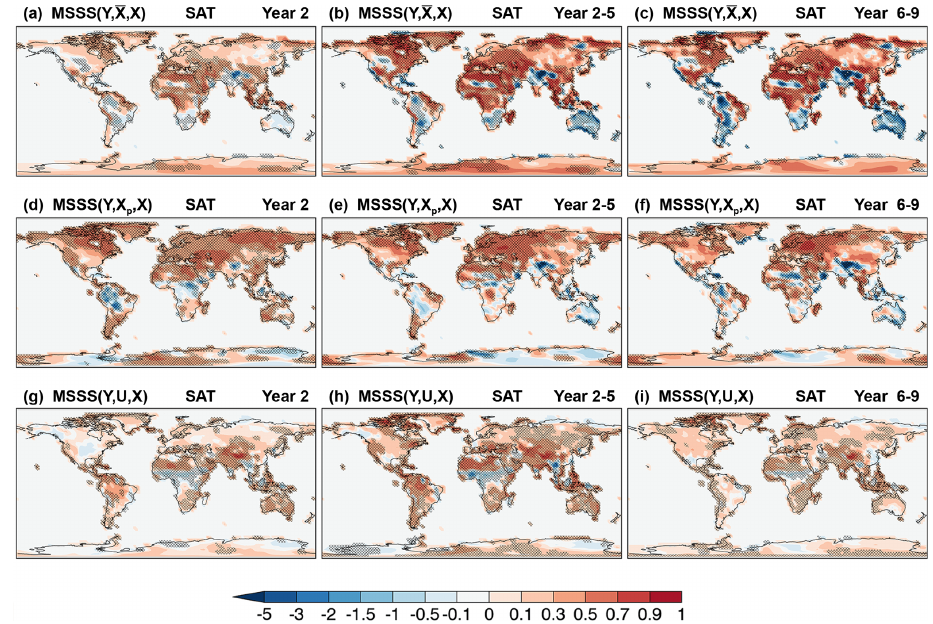
Figure 11. Skill of CanESM5 annual and multi-year mean near-surface air temperature hindcasts. MSSS of (a, d, g) Year 2, (b, e, h) Year 2– 5, and (c, f, i) Year 6–9 hindcasts, Y , relative to (a–c) observed climatology, X , (d–f) persistence forecast, X p , and (g–i) uninitialized simulations, U . The verifying observations are from the ERA-40 and ERA-Interim data sets (Appendix B). Cross-hatched regions indicate values significantly different from zero at the 90% confidence level.